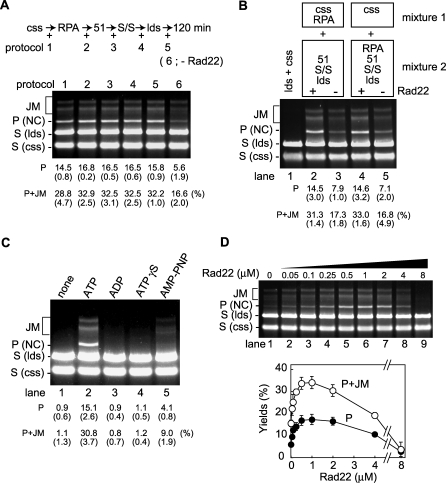
Rad22 Coordinates Strand Exchange(A) Effect of the order of Rad22 addition. Various protocols, indicated by numbers, were tested (upper panel). Rad22 was added at the time point indicated by the plus sign (+). The incubation time of each step (arrows) was 5 min. Rad22 was added 2.5 min after the beginning of each indicated step. Samples from each of the reactions (lower panel) were separated by agarose gel electrophoresis. Protocols 1 to 5 gave similarly high levels of strand exchange.(B) Rad22 abrogates the strict requirement for a specific order of protein addition to the strand exchange reaction. The indicated mixtures (1 and 2) were prepared separately, and the reactions were initiated by combining both mixtures and incubating at 37 °C for 120 min.(C) ATP hydrolysis is required for Rhp51-mediated strand exchange. The reactions contained Rad22, Swi5-Sfr1, Rhp51 and RPA, and the indicated nucleotides. The reaction conditions were the same as in Figure 1C. The values indicated below each lane in (A) to (C) are average percentages of P and P + JM obtained in three independent experiments. The s.d. is indicated in parentheses.(D) Substoichiometric amounts of Rad22 stimulate Rhp51-mediated DNA strand exchange. An agarose gel containing reactions with increasing concentrations of Rad22 is shown in the upper panel. The graph below shows the yields of the NC product (filled circles) and the total yields of JM intermediates plus the NC product (open circles). The values and error bars are average percentages and s.d. obtained from three independent experiments.